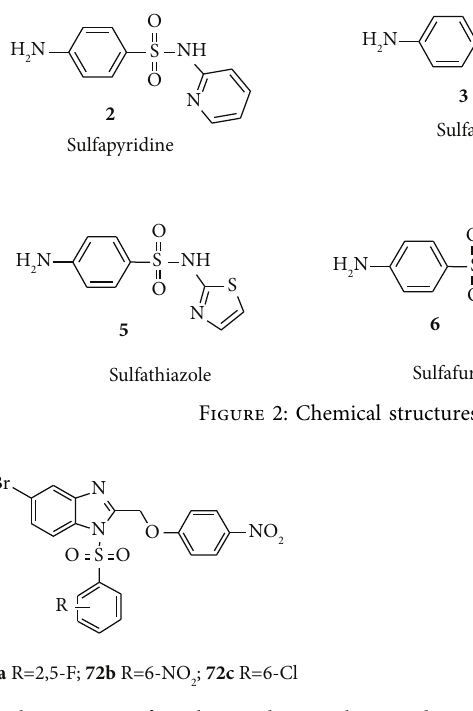
Figure 3: Chemical structures of antibacterial active benzimid- azole-sulfonyl